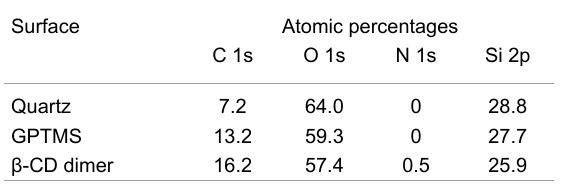
Table 1: Surface composition of unmodified, epoxy-activated and β -CD-dimer-grafted quartz.